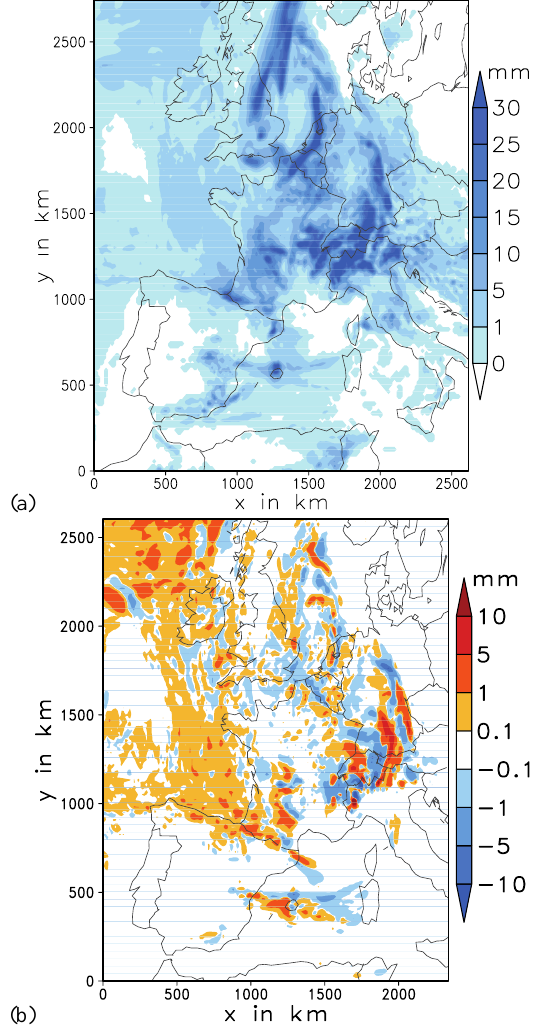
Fig. 9. (a) Accumulated precipitation amount in simulation A for 19–20 August 2005, (b) difference of the accumulated precipitation amount between simulation A and B for 19–20 August